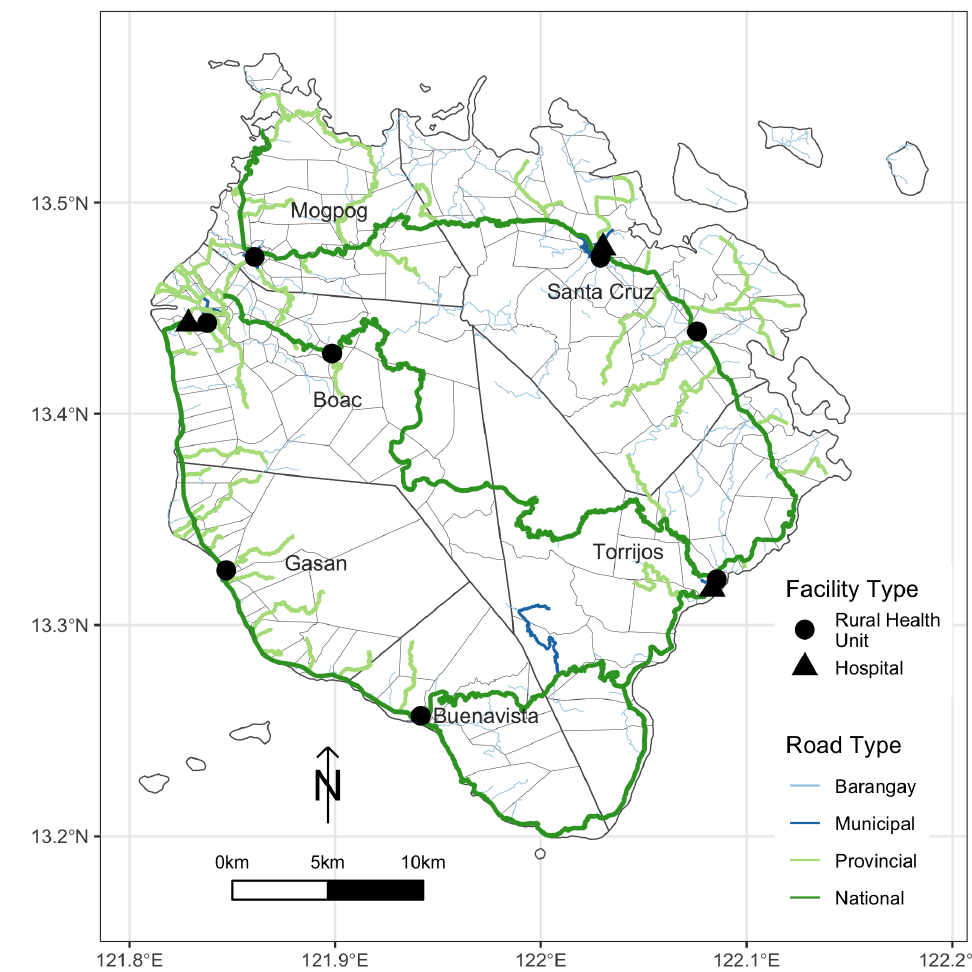
Figure 1. Map of healthcare facilities and road network in the province of Marinduque. Note that the thicker black lines in the map represent the municipal boundary, while the grey black lines are the village